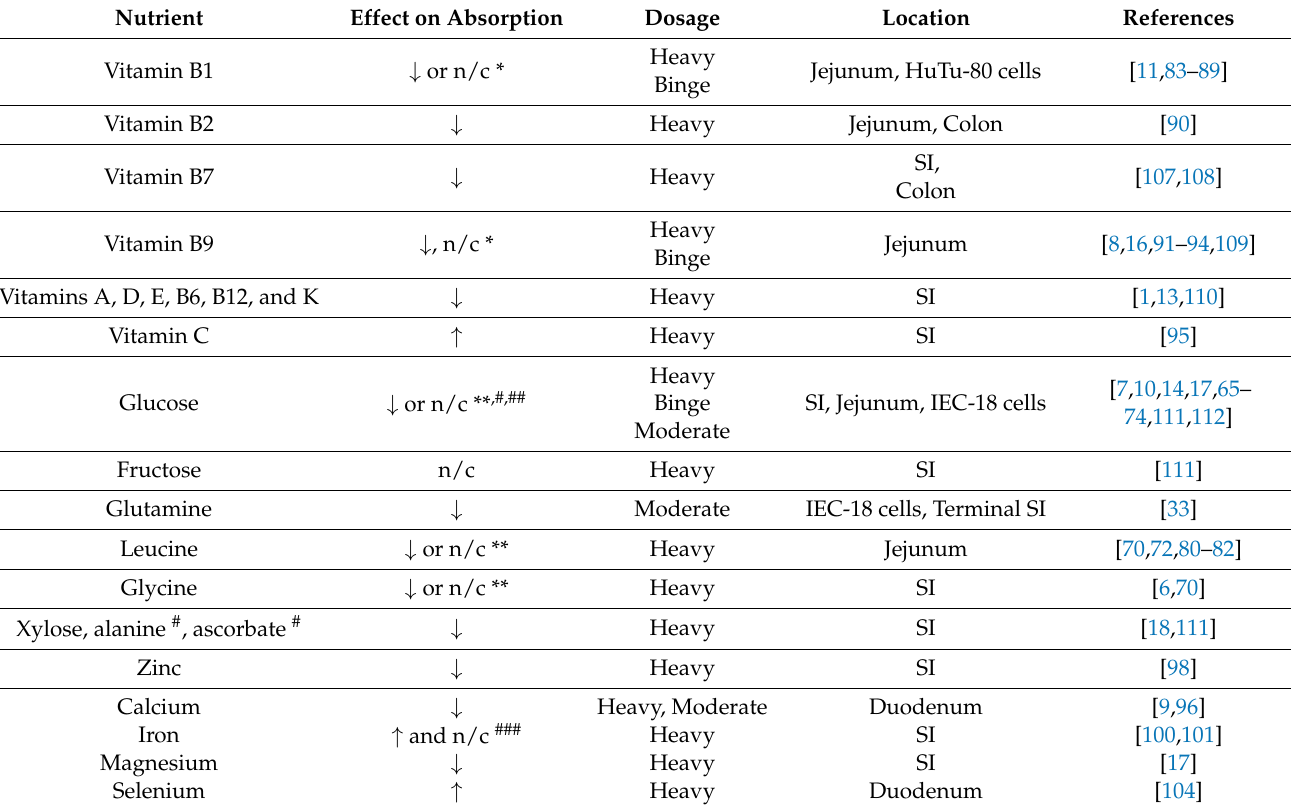
Table 2. Summary of the Main Studies on the Effect of Ethanol on Intestinal Nutrient